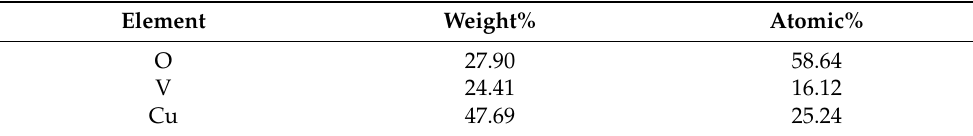
Figure 2. EDX spectrum of Cu-VO. The EDX spectrum showed the peaks of copper, vanadium, and oxygen. Table 1. Element proportion analysis of